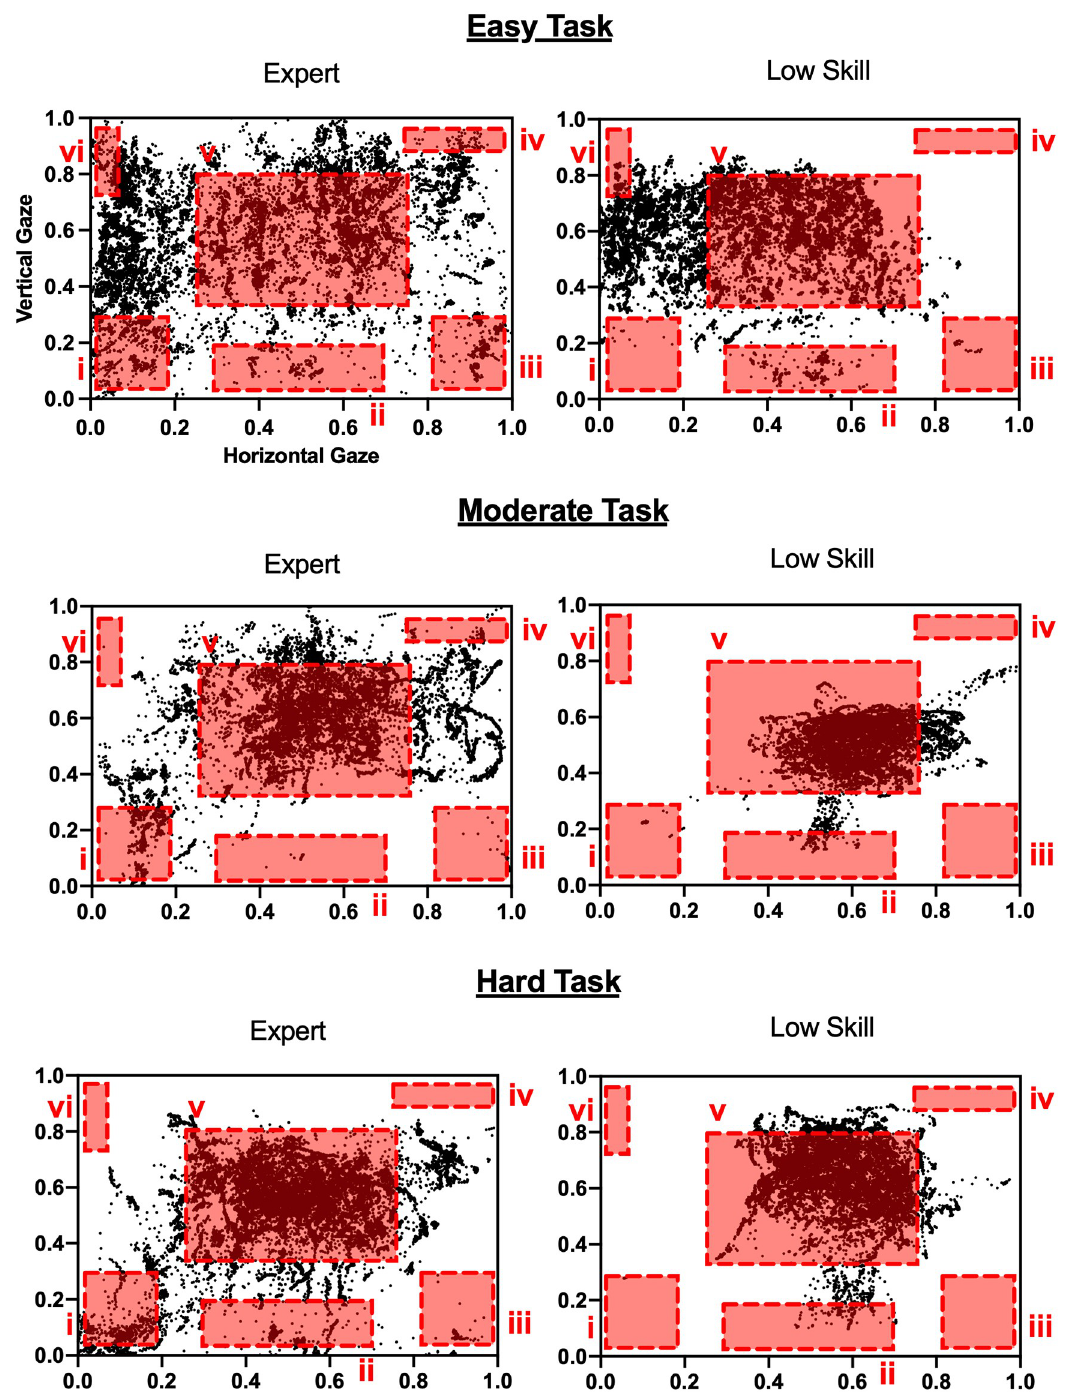
Fig 4. Examples of gaze distribution. Each black dot indicates one sample of measured gaze location. The darker areas represent denser gaze location concentrations, meaning that gaze movement was concentrated on that area. Each red square represents an AOI (See Fig 2). Areas which are not included in an AOI have relatively low importance. Vertical axis and horizontal axis are the numerical values obtained by normalizing the monitor size.